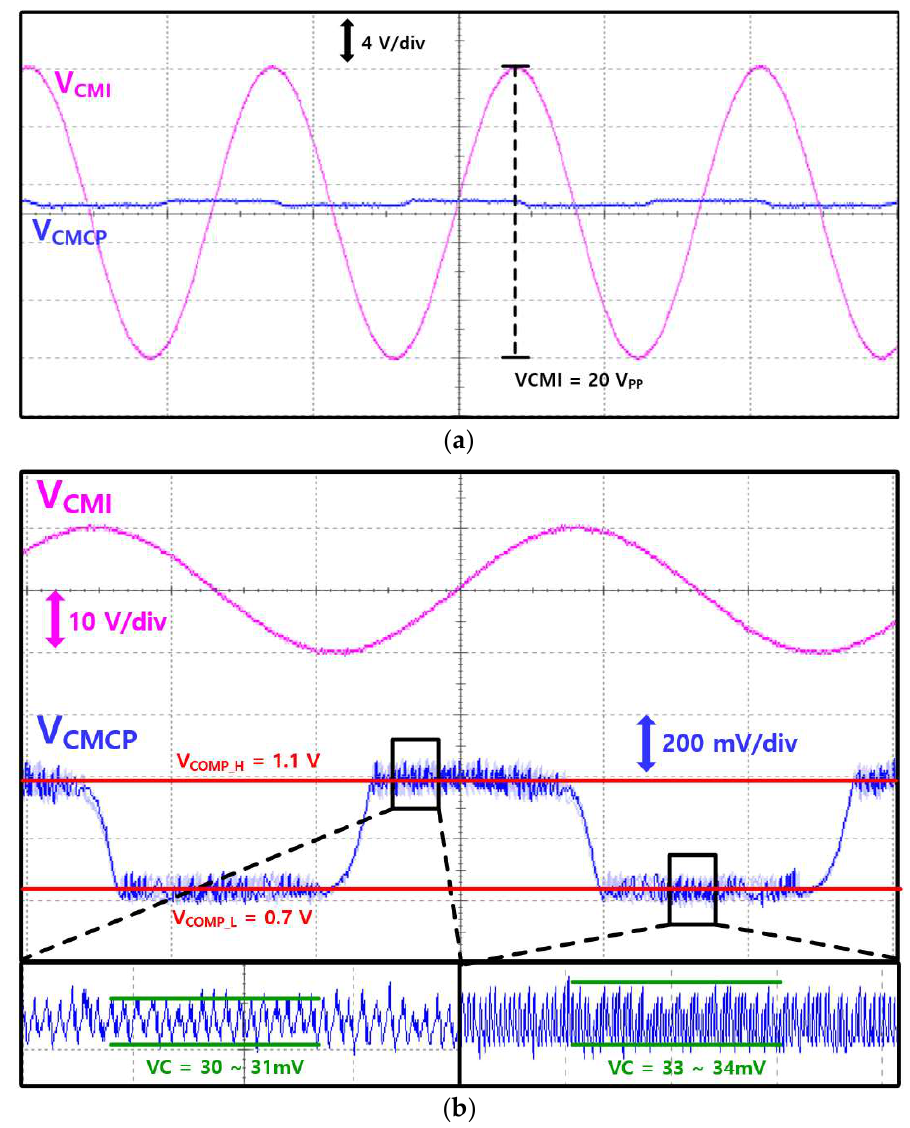
Figure 15. CMCP operation with 20-V PP CMI measurement results. ( a ) Compare with V CMI and V CMCP at same amplitude range; ( b ) magnified waveform.